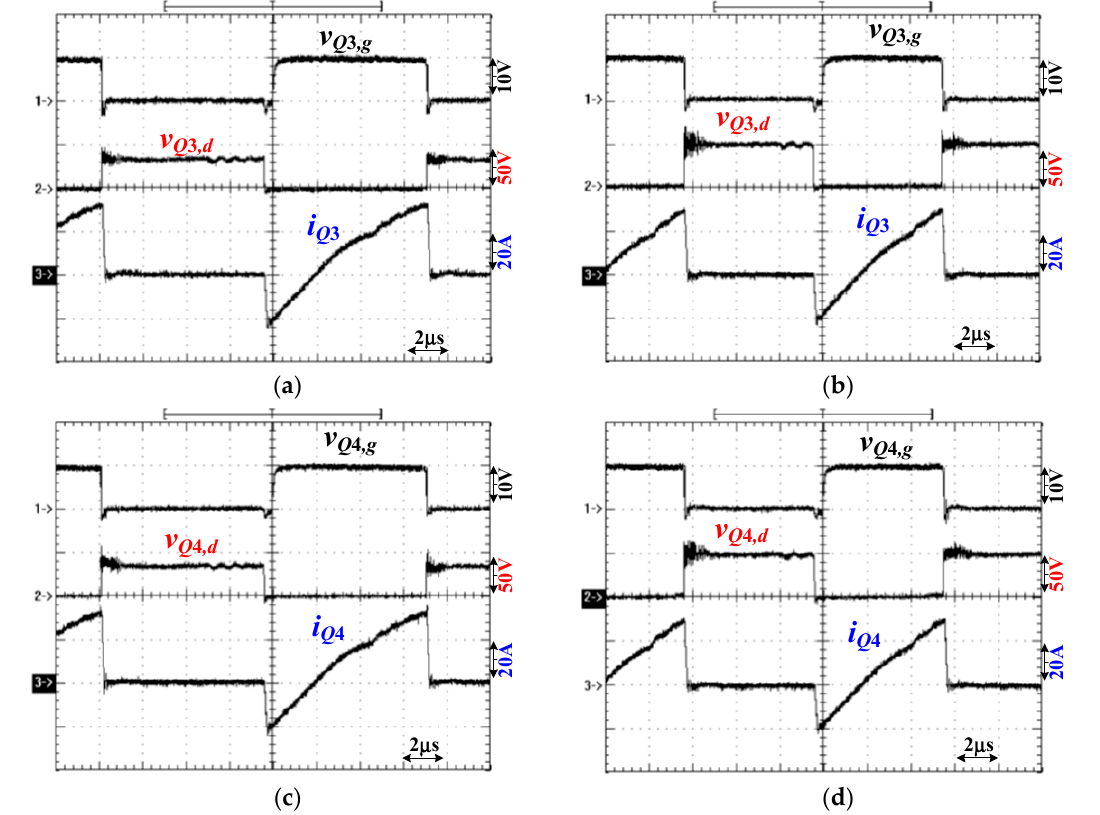
Figure 9. Test results of Q 3 and Q 4 under reverse power flow and 96W (20% load) output with ( a ) Q 3 at V 2 = 38 V, ( b ) Q 3 at V 2 = 52 V, ( c ) Q 4 at V 2 = 38 V, and ( d ) Q 4 at V 2 = 52 V.